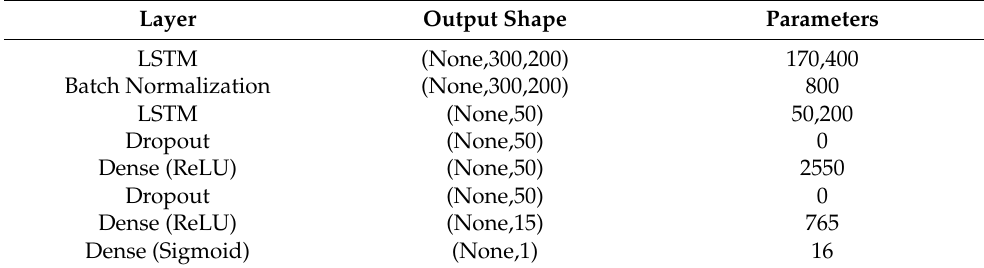
Table 2. The input, output, and hidden layers of the recurrent neural